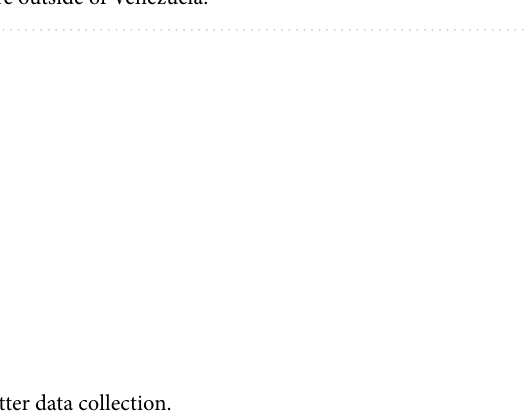
Table 1. Dataset statistics by language and location in terms of the number of tweets and users. The dataset is skewed towards Spanish speakers and users that are outside of Venezuela.